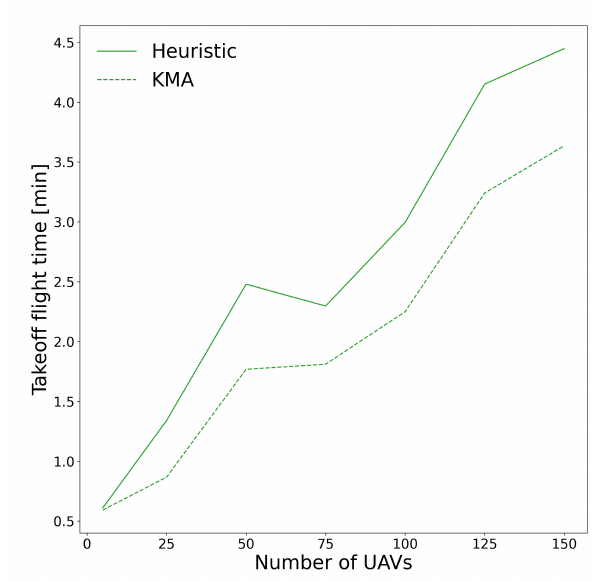
Figure 26. Take-off flight time between heuristic and KMA in the matrix formation.